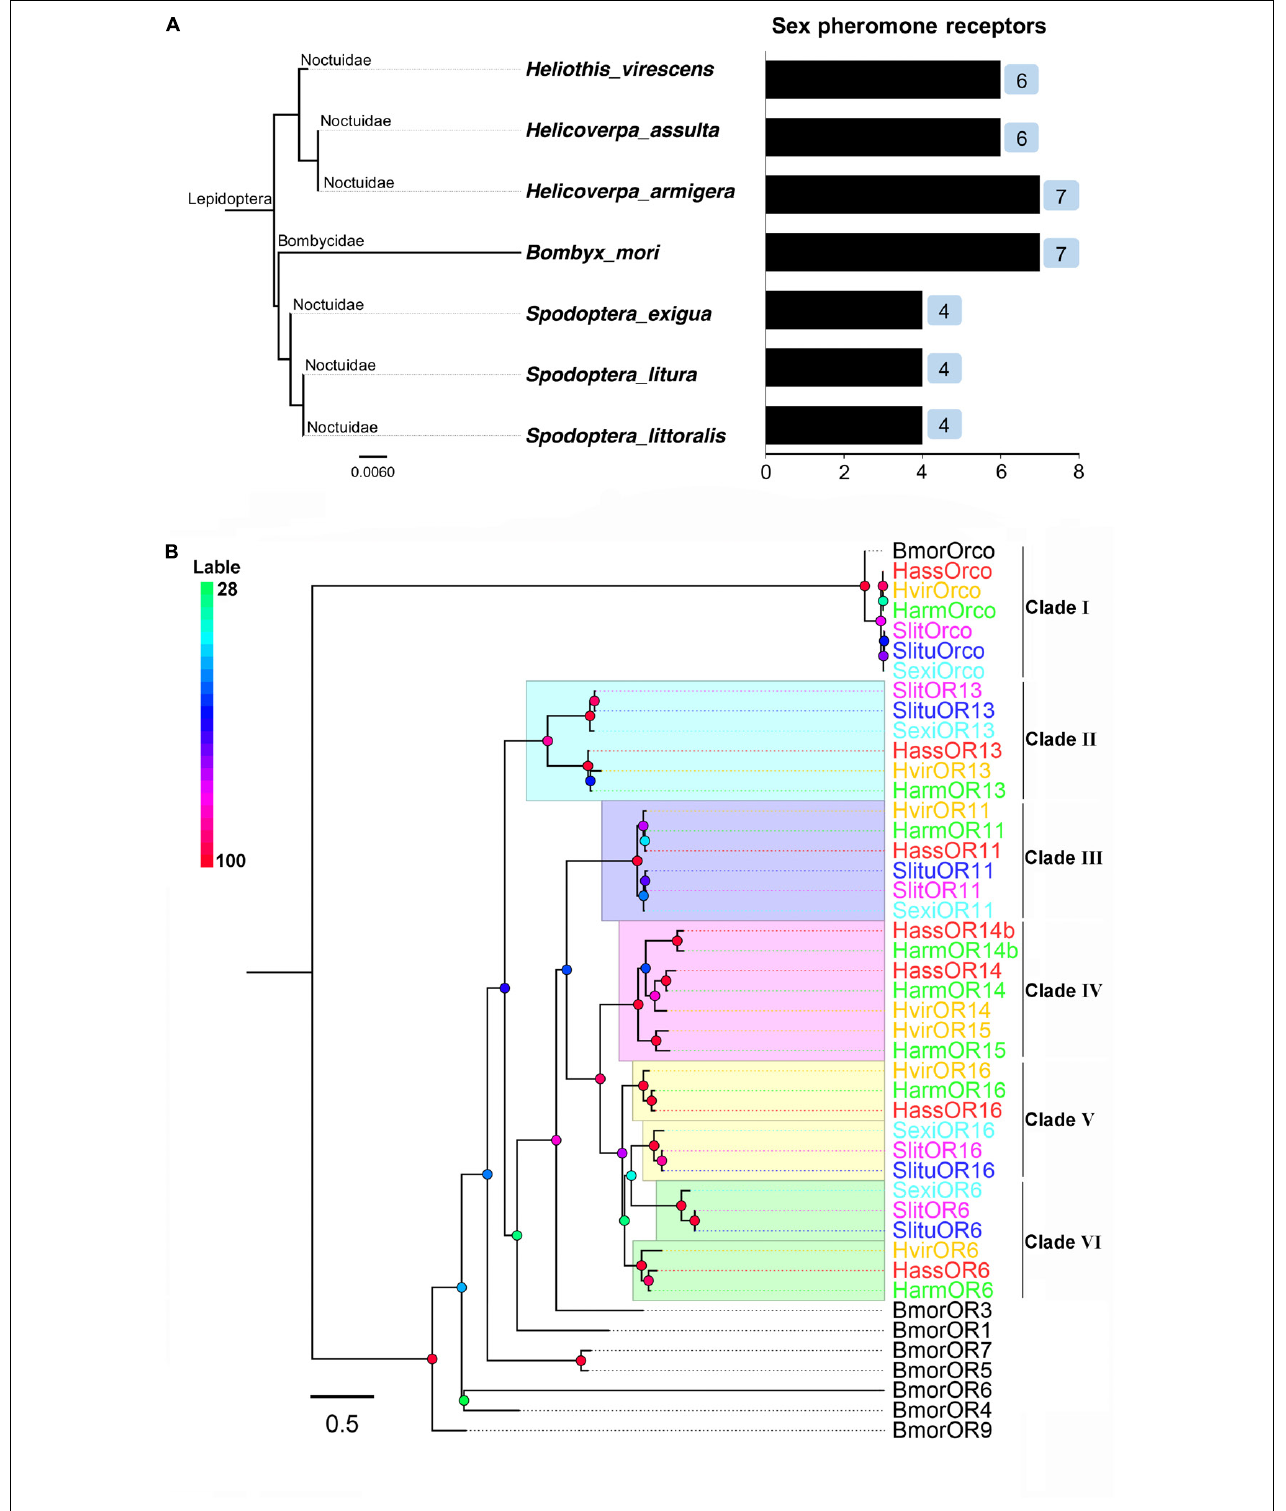
FIGURE 1 | The phylogeny of pheromone receptors (PRs) from seven moth species. (A) Phylogeny and number of PRs identified by species, including Helicoverpa armigera , H. assulta , Heliothis virescens , Bombyx mori , Spodoptera exigua , S. litura and S. littoralis. (B) A phylogenetic tree of PR genes in different Lepidoptera species. Six clades (I to VI) are shown in this tree representing Orco, OR13, OR11, OR14/15, OR16, and OR6 clades, respectively.